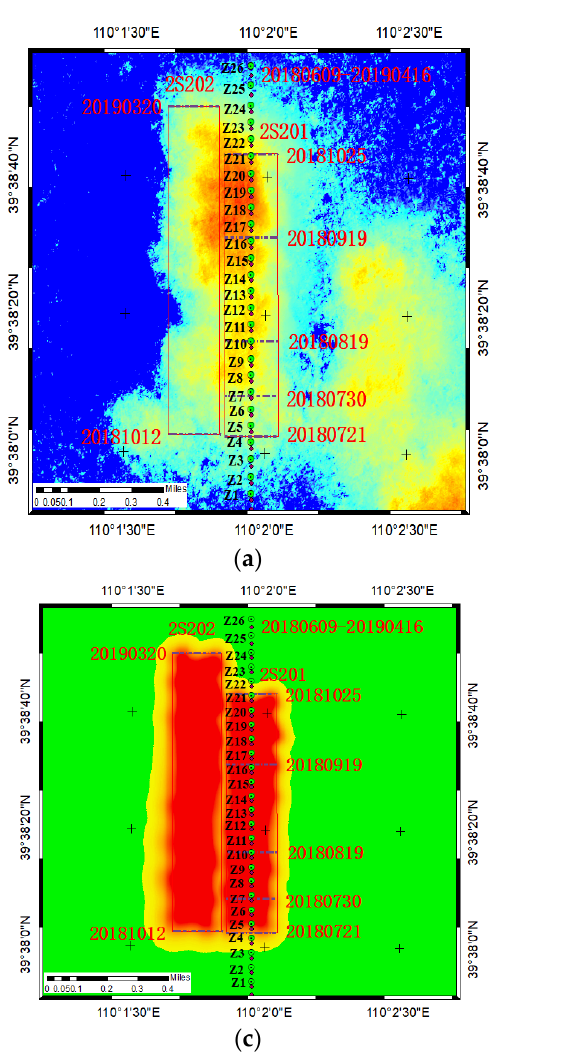
Figure 13. Cumulative subsidence obtained by three methods: ( a ) cumulative subsidence by InSAR; ( b ) cumulative subsidence by UAV; ( c ) cumulative subsidence by fusion method; Z1 to Z26 are GNSS monitoring point; 2S201 and 2S202 are working faces; the data is of production.